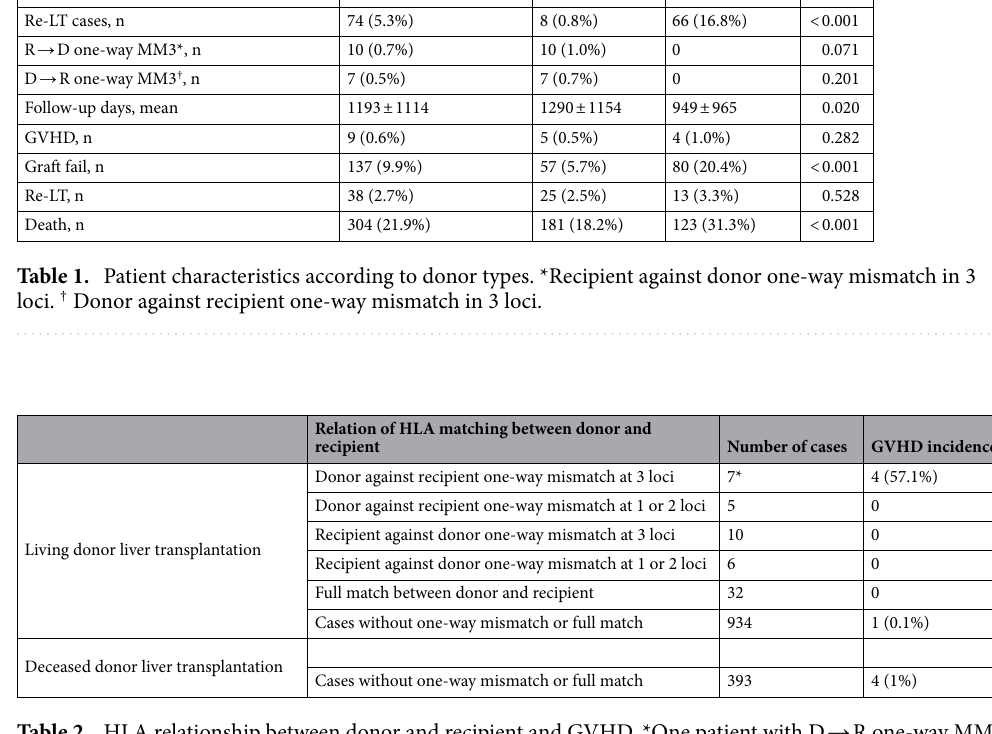
Table 2. HLA relationship between donor and recipient and GVHD. *One patient with D → R one-way MM3 had primary graft non-function, received re-LT on postoperative day#4, leading to change of HLA relationship.